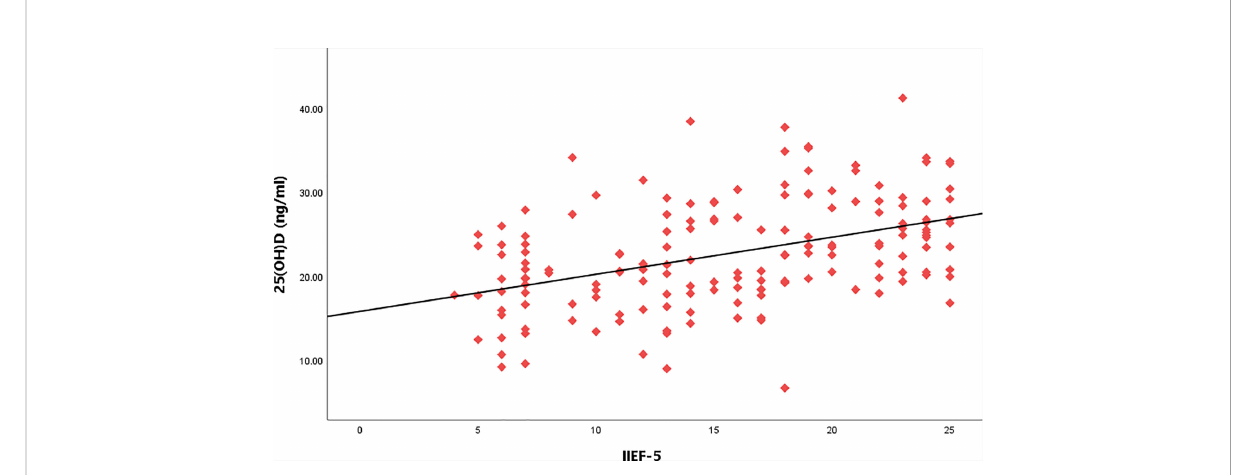
FIGURE 4 Relationship between IIEF-5score and serum 25(OH)D